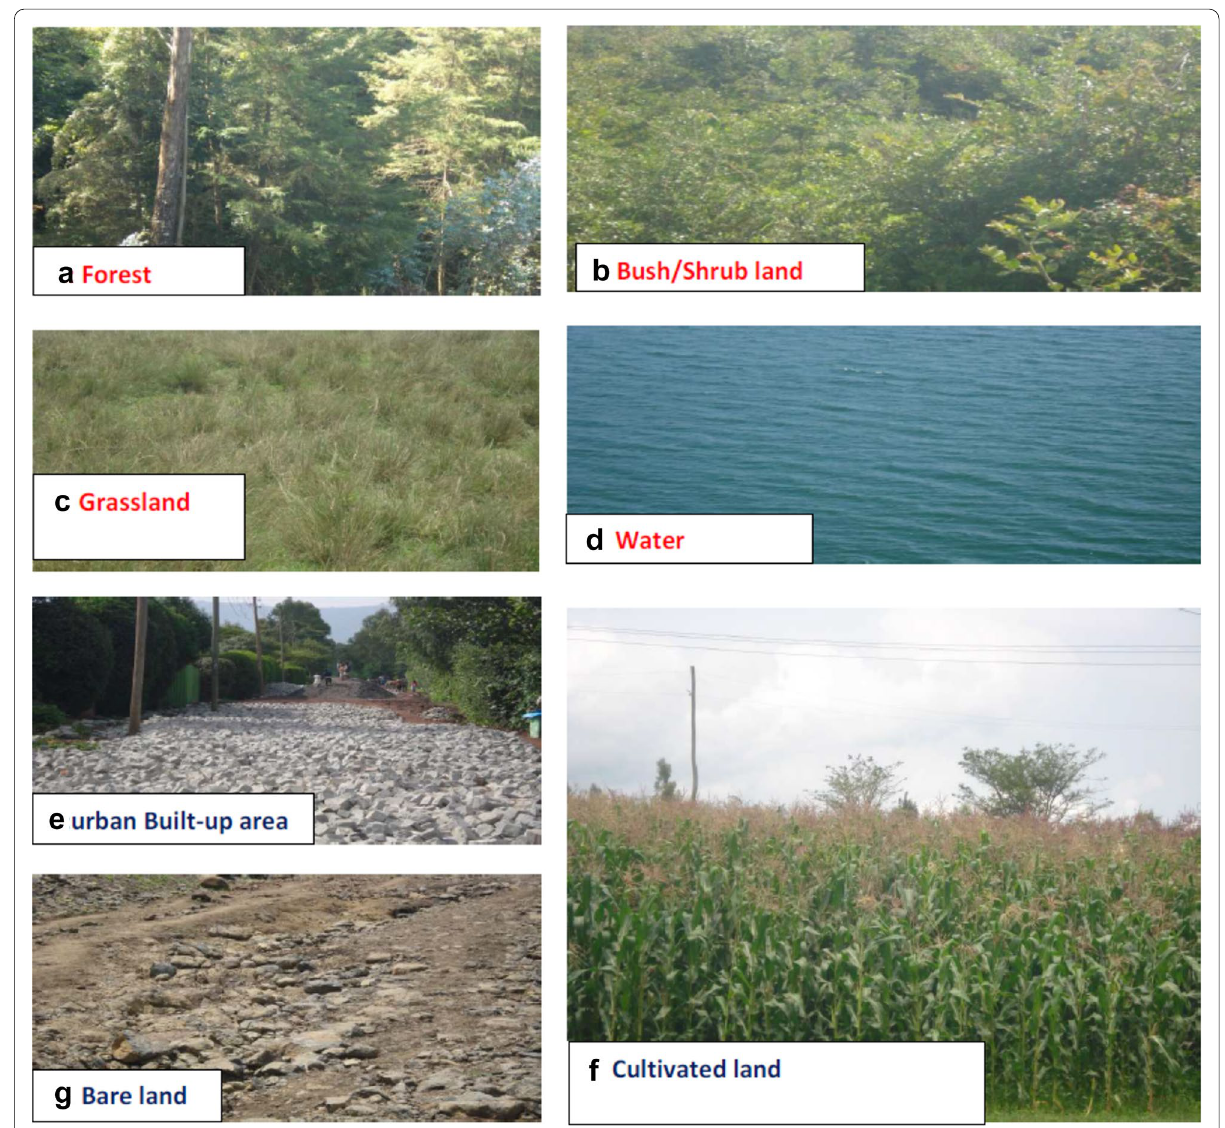
Fig. 2 Composition of land use and land cover in Huluka Watershed: a Forest, b Bush/Shrub land, c Grassland, d Waterbody, e Urban built-up, f Cultivated land, and g Bare land ( Source: Participant Observation